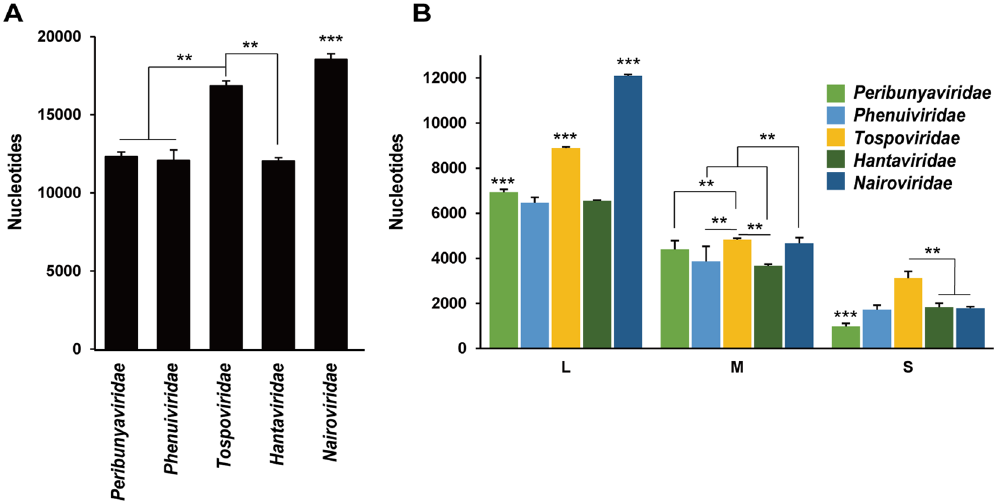
Figure 4. Genome length of bunyaviruses. ( A ) The total genome length (L segment + M segment + S segment) of each virus family. ( B ) The lengths of the L, M, and S segments in each virus family. Bars represent the means and standard deviations. Virus species in the following families were examined: Peribunyaviridae (n = 56), Phenuiviridae (n = 47), Tospoviridae (n = 19), Hantaviridae (n = 24), and Nairoviridae (n = 20). ** p < 0.01, one-way analysis of variance followed by Tukey’s test, *** p < 0.01, in comparison to the other four